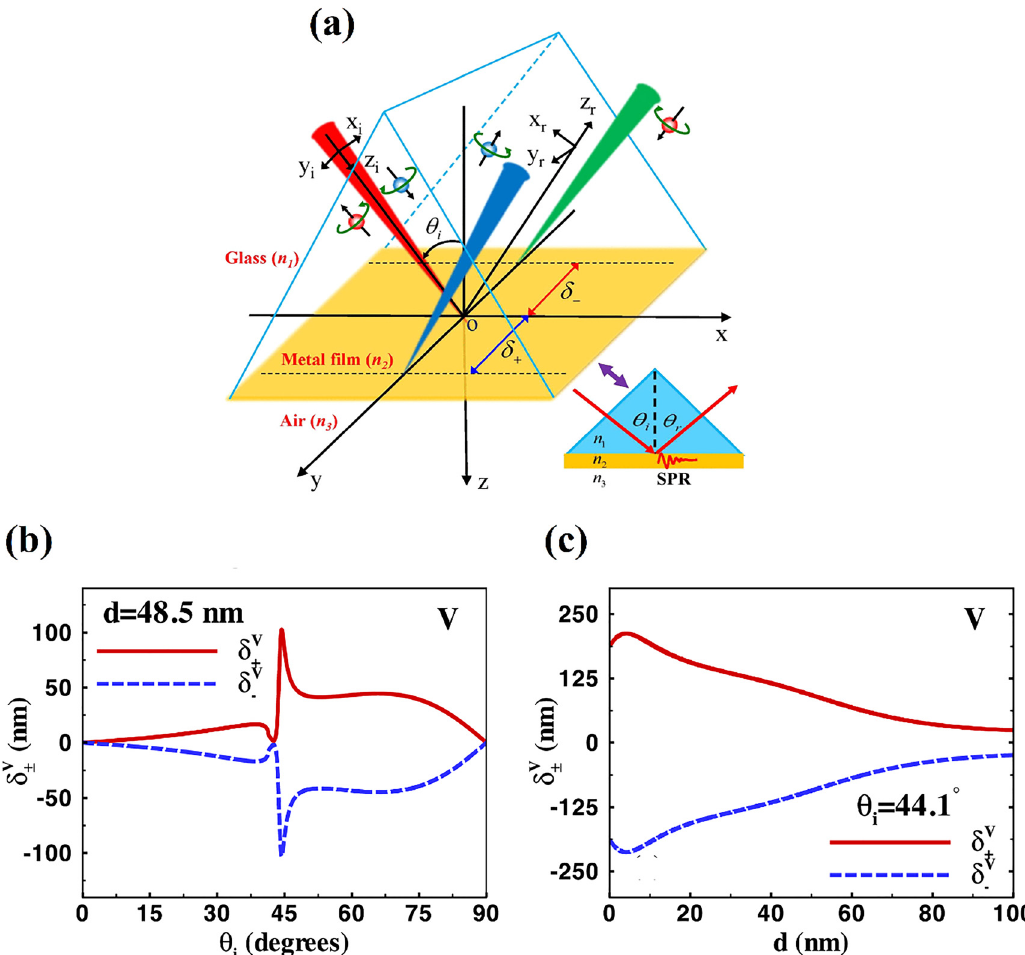
Figure4: a,IllustrationofthePSHEinametal/glassfilmwiththeSPReffect;b,theregulationofthePSHEshiftswiththelightincidentangle;c, the changing of the PSHE shifts with the thickness of the metal film